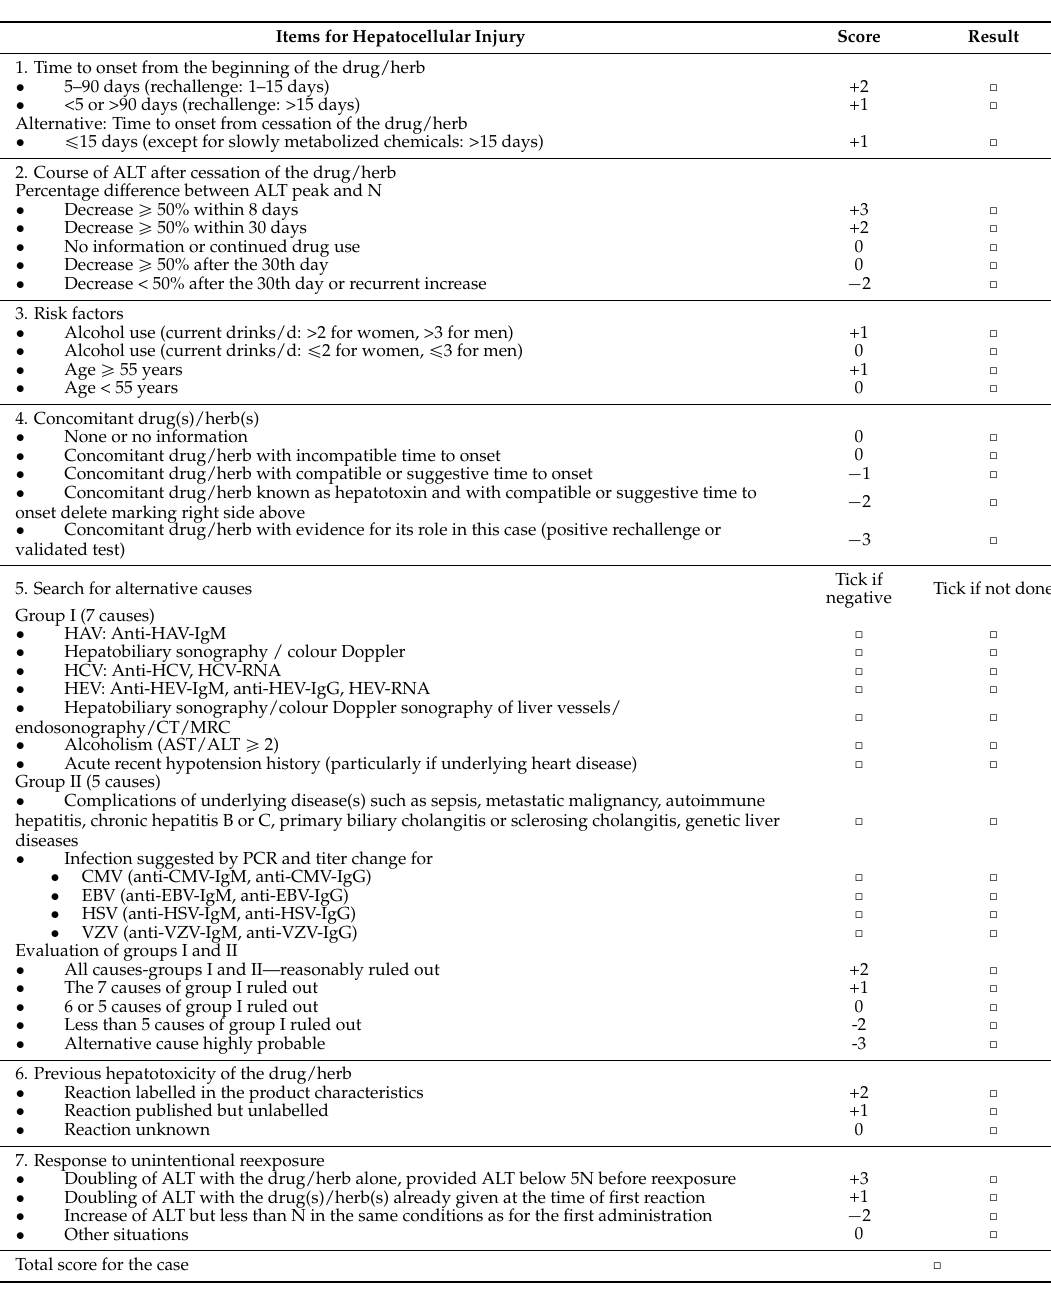
Table 2. Updated RUCAM for the hepatocellular injury of DILI and HILI. The items specifically refer to the hepatocellular injury rather than to the cholestatic or mixed liver injury (shown in Table 3). Abbreviations: ALT, Alanine aminotransferase; AST, Aspartate aminotransferase; CMV, Cytomegalovirus; CT, Computer tomography; DILI, Drug induced liver injury; EBV, Epstein Barr virus; HAV, Hepatitis A virus; HBc, Hepatitis B core; HBsAg, Hepatitis B antigen; HBV, Hepatitis B virus; HCV, Hepatitis C virus; HEV, Hepatitis E virus; HILI, Herb induced liver injury; HSV, Herpes simplex virus; MRC, Magnetic resonance cholangiography; N, upper limit of the normal range; RUCAM, Roussel Uclaf Causality Assessment Method; VZV, Varicella zoster virus. Total